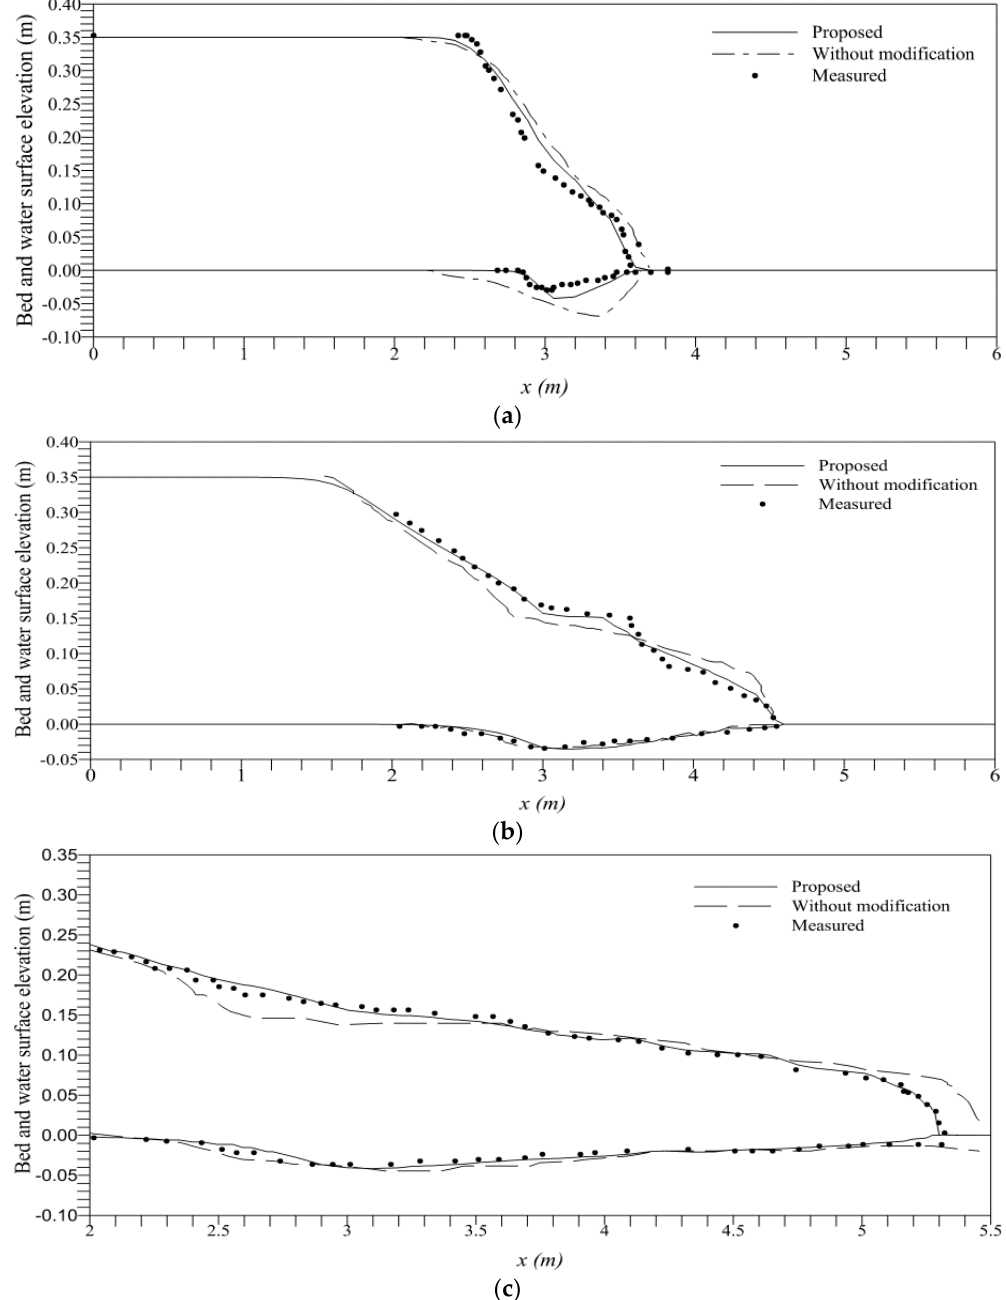
Figure 5. Numerical and experimental results of dam-break for configuration 1: ( a ) t = 0.25 s; ( b ) t = 0.75 s; and ( c ) t = 1.25 s.